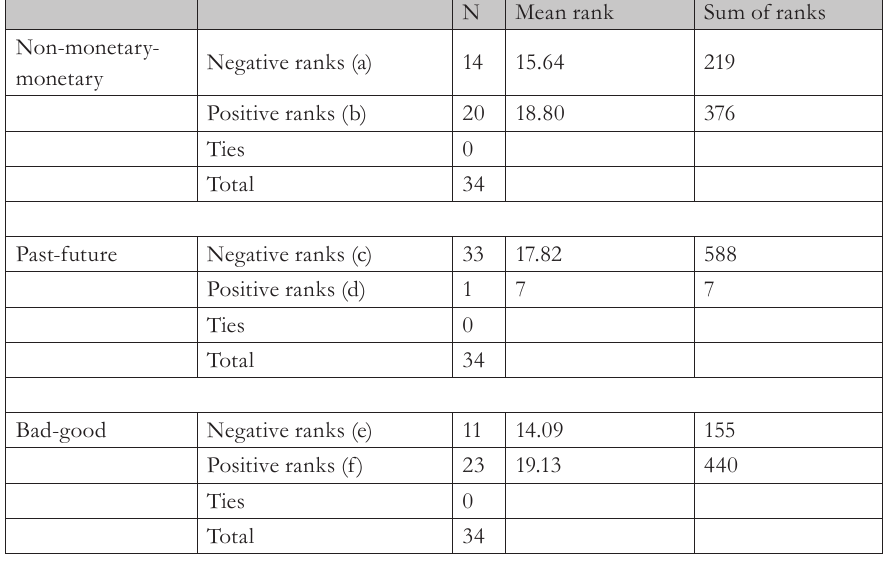
Tab. 4 – Wilcoxon signed rank test results. Source: own research